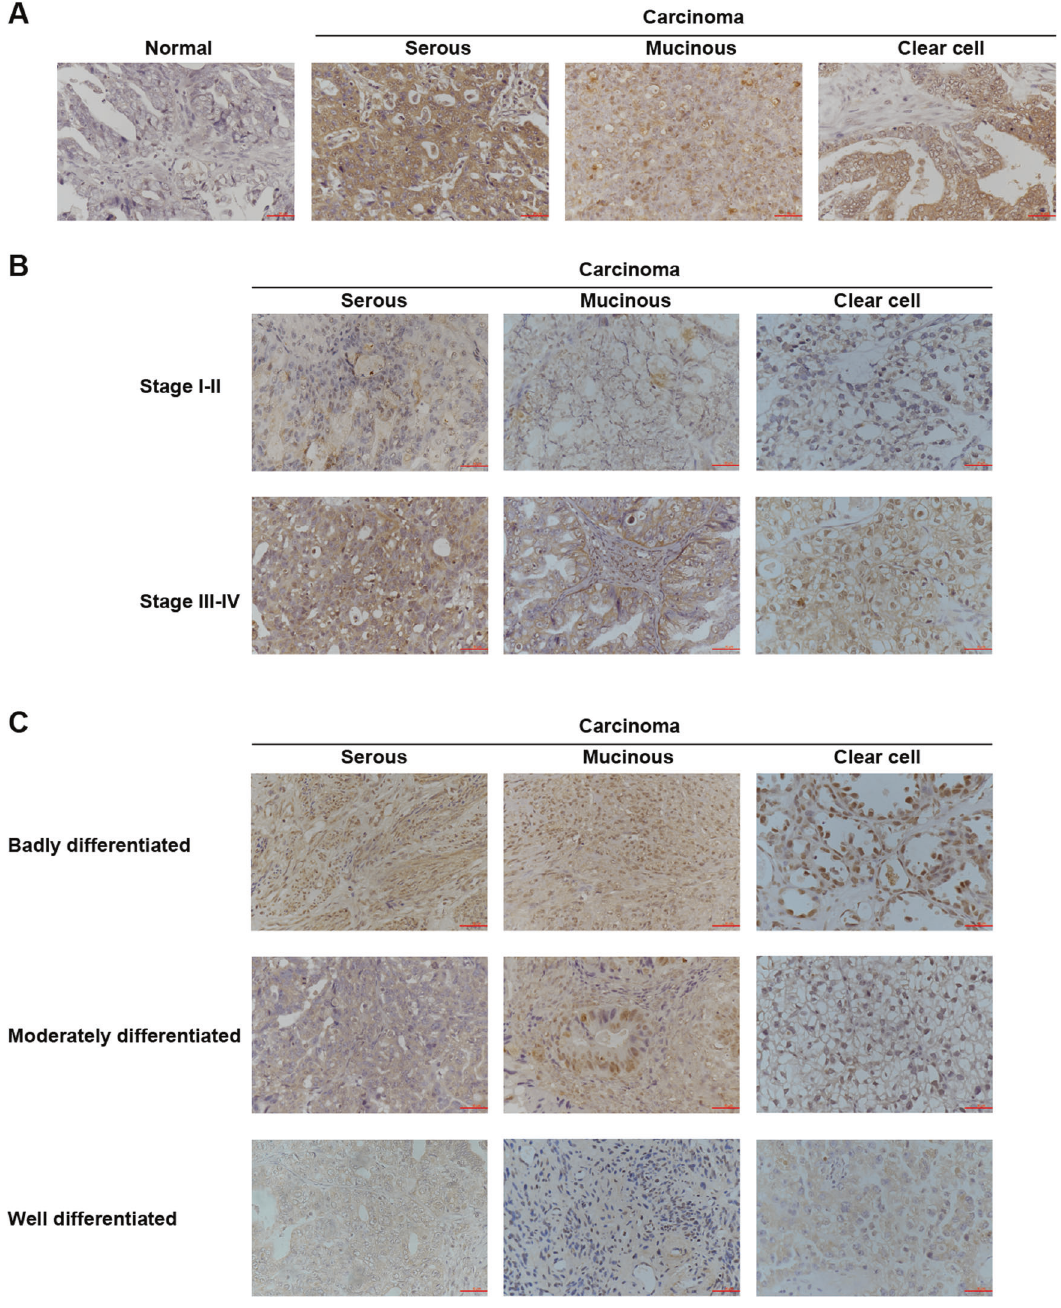
Fig. 1 PARD6A potentially correlates with ovarian cancer clinically. A Representative images of immunohistochemistry detections of protein levels of PAR6 α in serous, mucinous, and clear cell subtypes of ovarian cancer tissues versus normal ovarian epithial tissues. B Representative images of immunohistochemistry detections of protein levels of PAR6 α in Stages I-II versus Stages III-IV of serous, mucinous, and clear cell subtypes of ovarian cancer tissues. C Representative images of immunohistochemistry detections of protein levels of PAR6 α in poorly, moderately, and well differentiated ovarian cancer tissues in serous, mucinous, and clear cell subtypes. Scale bar = 50